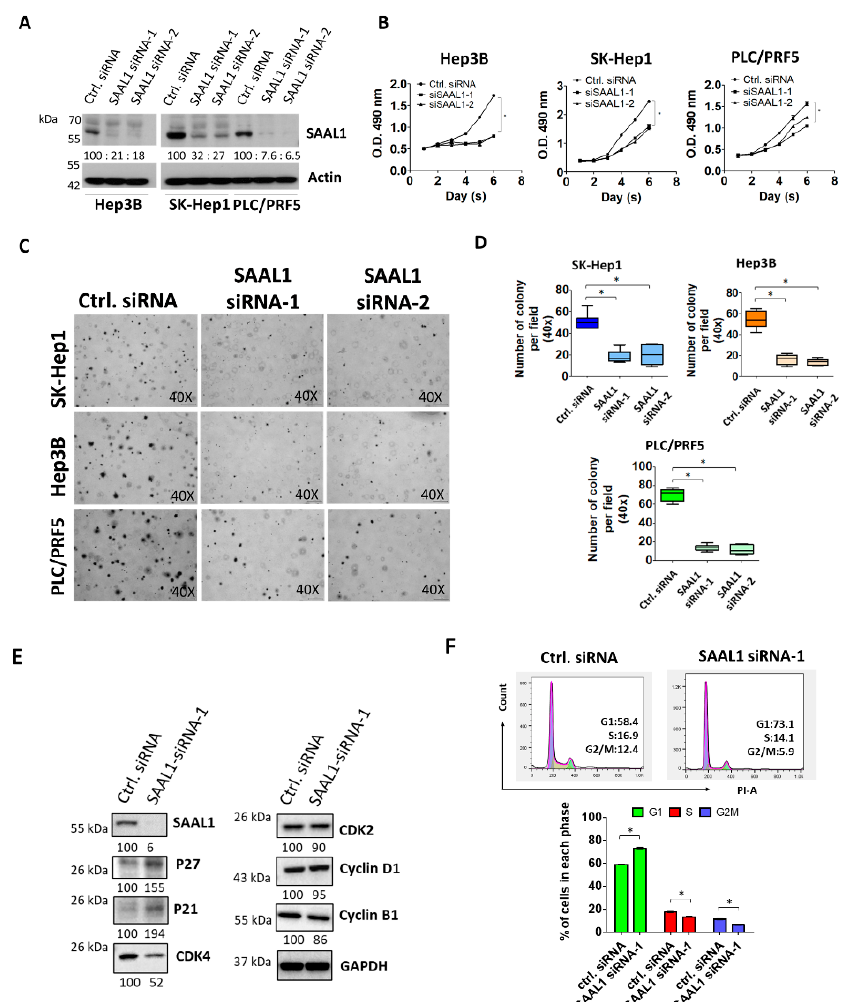
Figure 2. Depletion of SAAL1 expression impairs cell proliferation and 3D colony formation via inducing G1-phase cell cycle arrest. ( A ) Western blotting analysis of SAAL1 protein expression in three HCC lines transfected with SAAL1 siRNAs. Actin was served as an internal control. ( B ) Depletion of SAAL1 reduces cell proliferation of HCC cells. * p < 0.05. ( C ) Inhibition of SAAL1 expression reduces the colony-forming abilities of HCC cells in a 3D soft agar culture. (40 × , brightfield). ( D ) The quantitative results of the 3D soft agar assay. ( E ) Western blotting analysis of cell cycle proteins in SAAL1-depleted SK-Hep1 cells and the control SK-Hep1 cells. ( F ) Flow cytometry analysis of cell cycle progress in SAAL1-depleted cells and the control cells. * p < 0.05. Each experiment was performed in triplicate and was repeated three times. The representative data were shown as pictures.